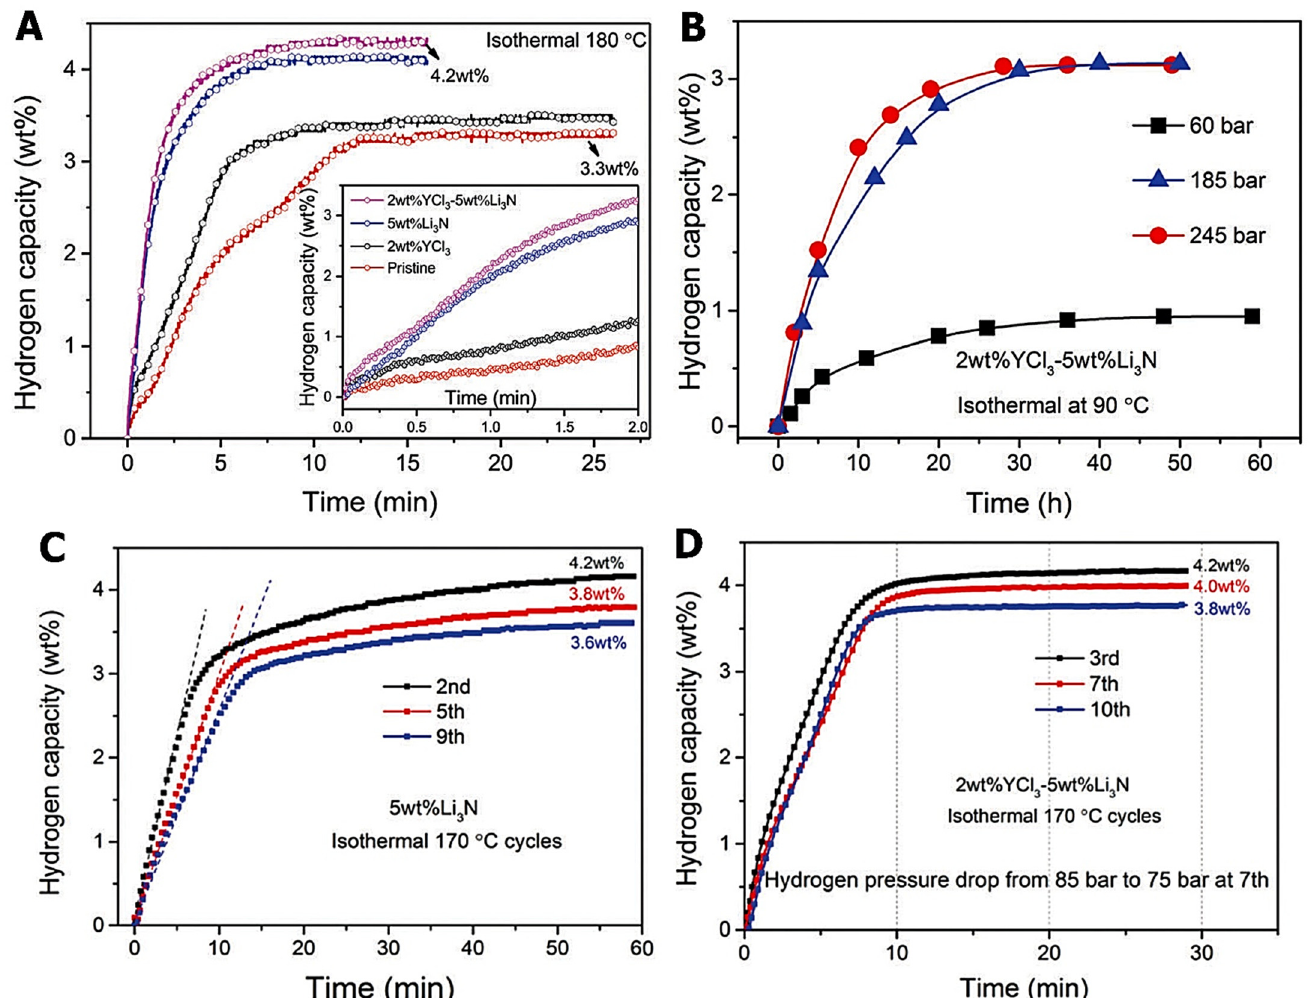
Figure 16. ( A ) Isothermal hydrogenation curves of the pristine system, and 2 wt% YCl 3 , 5 wt% Li 3 N and 2 wt% YCl 3 -5 wt% Li 3 N-co-added samples at 180 °C and 50 bar. Inset plot: isothermal hydrogenation curves of these samples during the first 2 min; ( B ) isothermal hydrogenation of the 2 wt% YCl 3 -5 wt% Li 3 N-co-added sample at 90 °C under 60, 185 and 245 bar of H 2 , respectively. (Before hydrogenation, all the samples were fully dehydrogenated under isothermal conditions at 180 °C). Isothermal hydrogenation curves of ( C ) the second, fifth and ninth cycle of the 5 wt% Li 3 N-added sample, and ( D ) the third, seventh and tenth cycle of the co-added sample, at 170 °C and under 85 bar of H 2 . The H 2 pressure during the absorption measurement decreased from 85 to 75 bar in the 7th cycle. This might be one of the reasons for the reduced reversible hydrogen capacity. This figure was reprinted with permission from ref. [177].